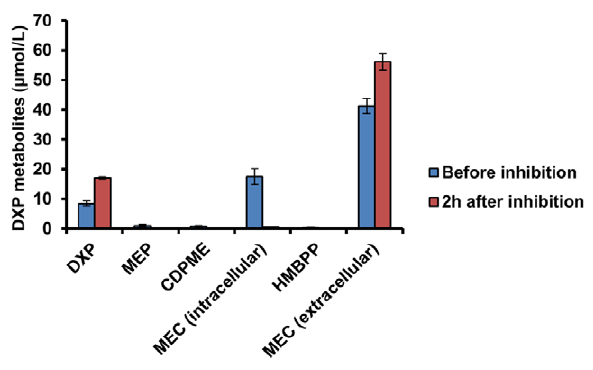
Figure 7. The effects of fosmidomycin inhibition of dxr on DXP metabolism. Twenty five microgram per milliliter fosmidomycin was used to inhibit MEC biosynthesis at 4 h after induction, and the metabolites of BL21 Gold (DE3) harboring pET-SIDF and pAC-LYC were analyzed before and 2 h after inhibition; Presented data were average of triplicates and standard errors were drawn on the